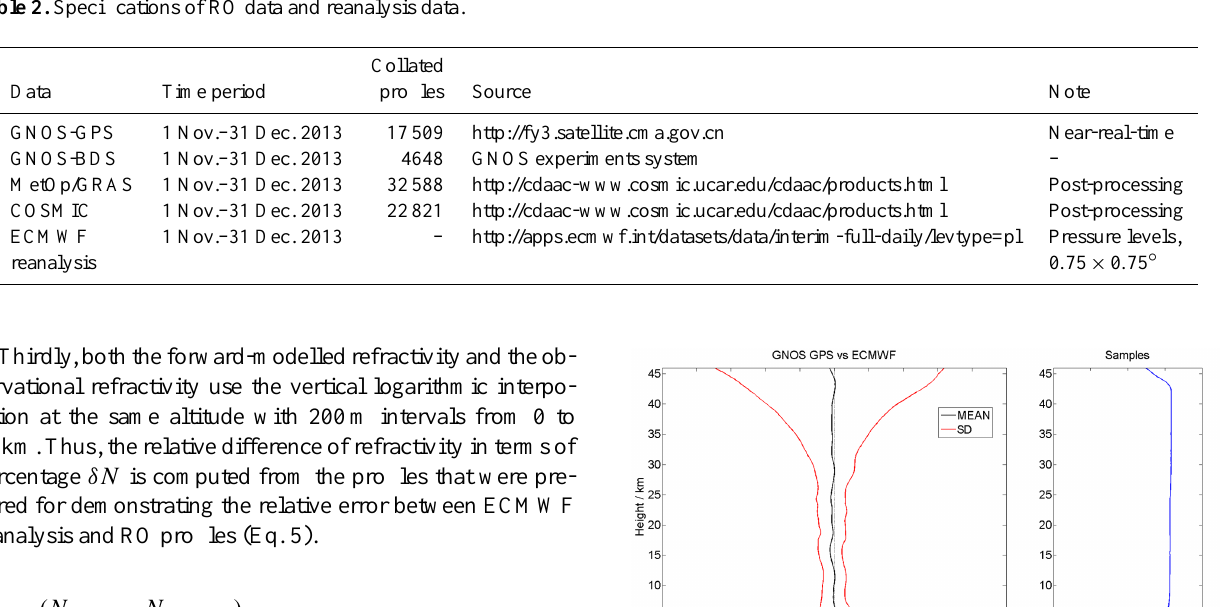
Table 2. Specifications of RO data and reanalysis data.